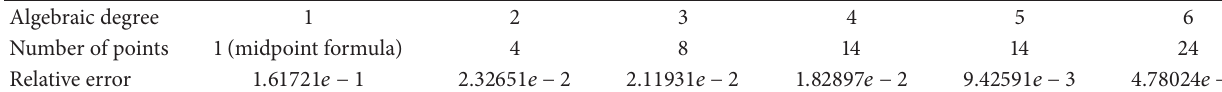
Table 2: The relative error changing with the algebraic degree.